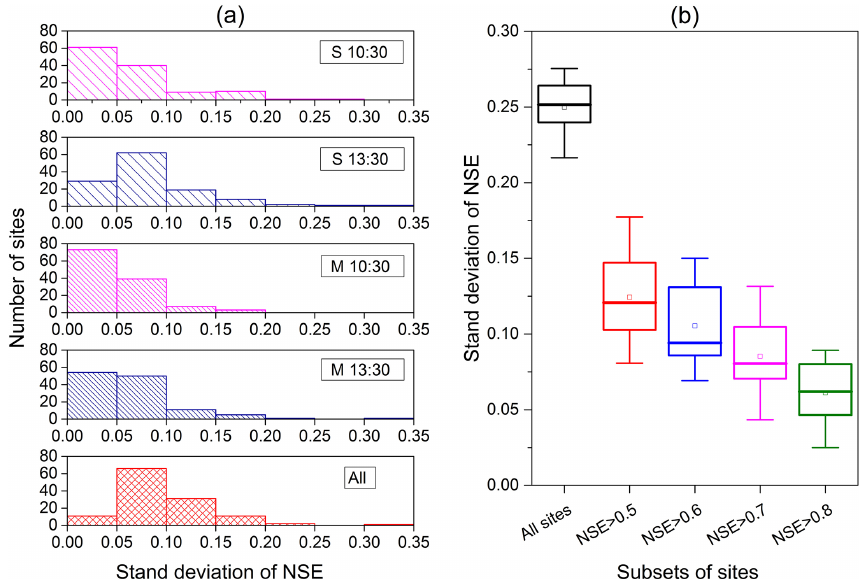
Figure 10. Standard deviation of NSE based on (a) different methods and (b) different sites. Note: in the left-hand-side figure, S and M represent different methods by the single- and multi-time values, respectively; “All” contains all upscaling schemes used in this study. In the right-hand-side figure, the site-to-site standard deviations of simulated NSE for every upscaling scheme are shown as columns of a box plot. The five columns represent all sites where the average NSE for all upscaling schemes is higher than 0.5, 0.6, 0.7, and 0.8, and the corresponding numbers of sites are 122, 118, 111, 97, and 67,